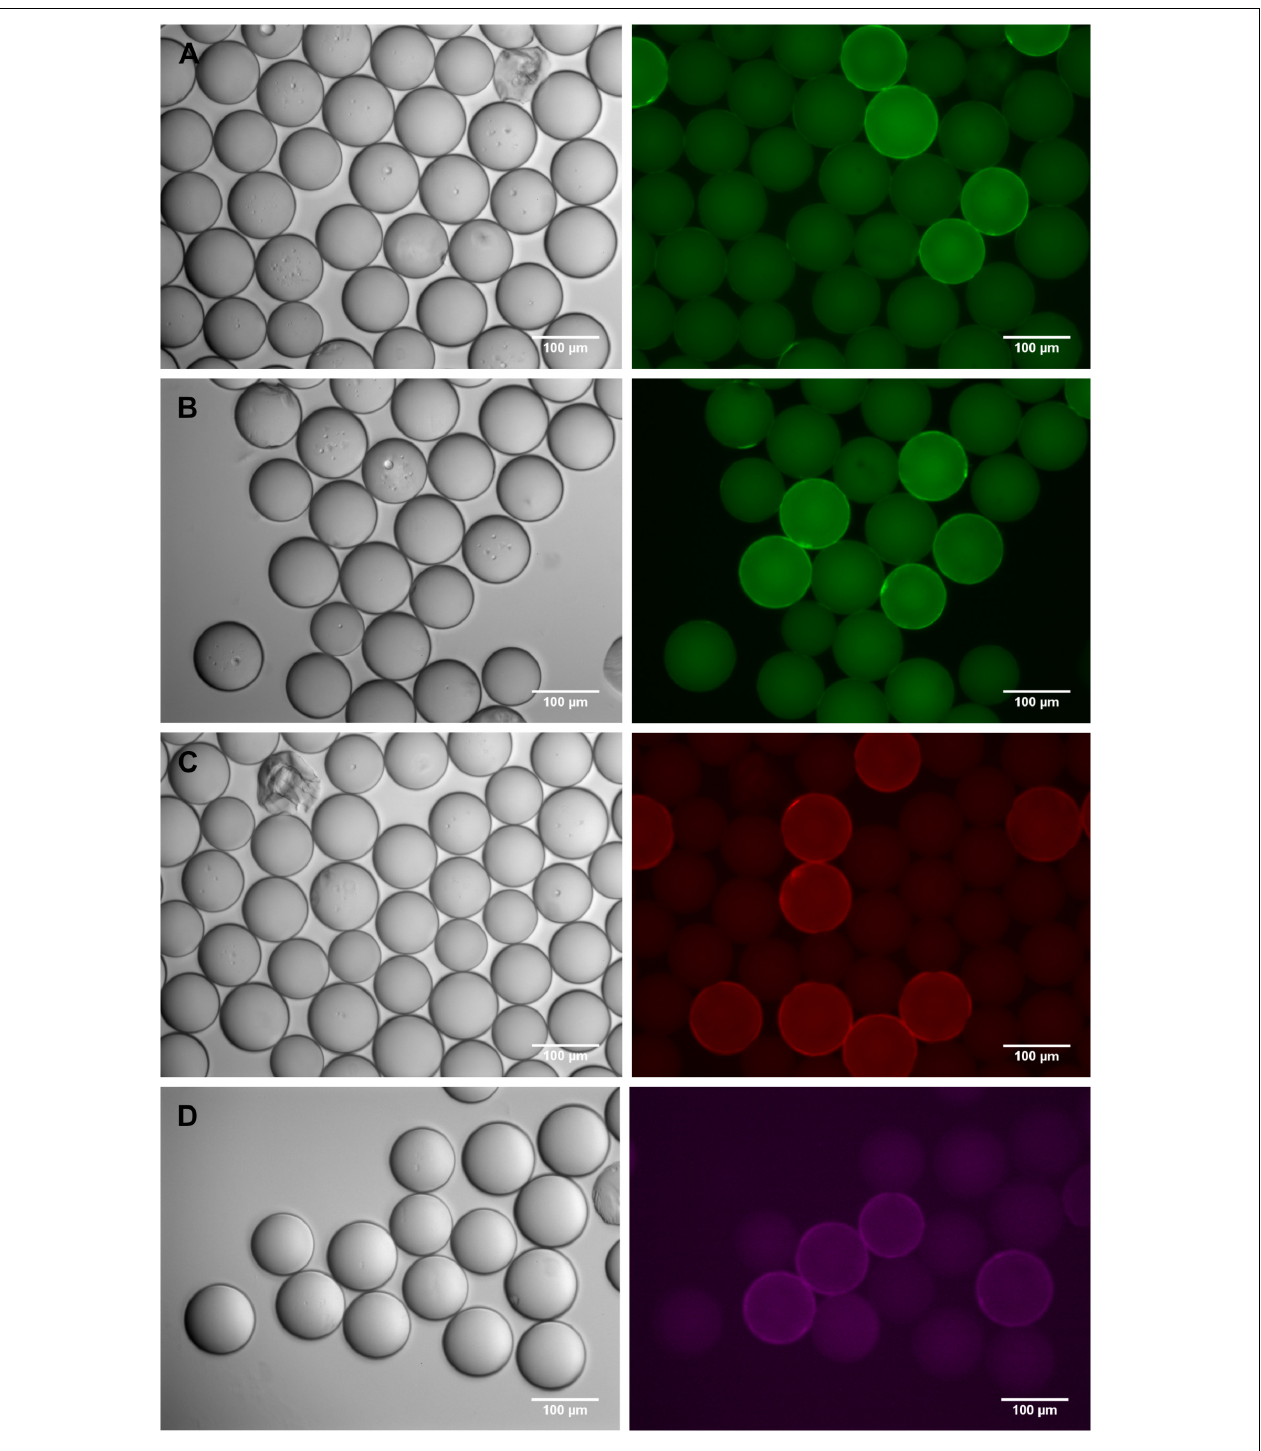
FIGURE 2 | Detection of c-myc-beads, diluted 1:10, in an artificial peptide library of scrambled c-myc beads. Different concentrations of anti-c-myc IgE were used and IgE-binding was detected with various fluorophore-labeled anti-IgE antibodies. Phase contrast images are shown on the left, corresponding fluorescence images of the appropriate channel on the right side of the panel. (A) 100 ng/ml anti-c-myc IgE detected with FITC-labeled monoclonal anti-human IgE (FITC-channel); (B) 20 ng/ml anti-c-myc IgE detected with polyclonal anti-human IgE labeled with DyLight488 (FITC-channel); (C) 20 ng/ml anti c-myc IgE detected with polyclonal anti-human IgE labeled with DyLight550 (rhodamine-channel); (D) 2 ng/ml anti c-myc and polyclonal anti-human IgE labeled with DyLight650, (Cy5-channel). High autofluorescence background is predominant in the green channel (B) , but true positives can be distinguished by presence of a more brilliant “corona.” Autofluorescence decreases at higher wavelength (C,D) . Quantitation of fluorescence intensities can be found in the Supplementary Figure 2 .